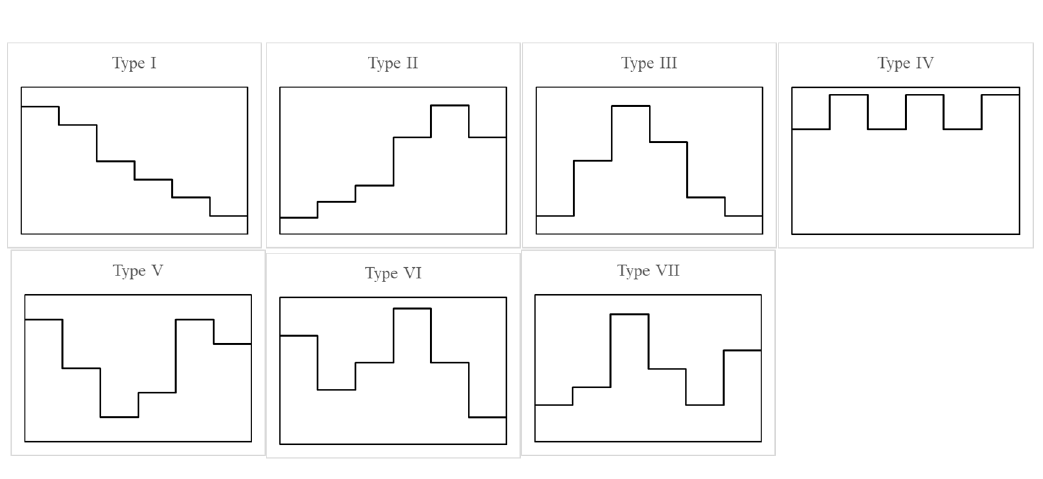
Figure 2. Profile of seven types of mode hyetographs.